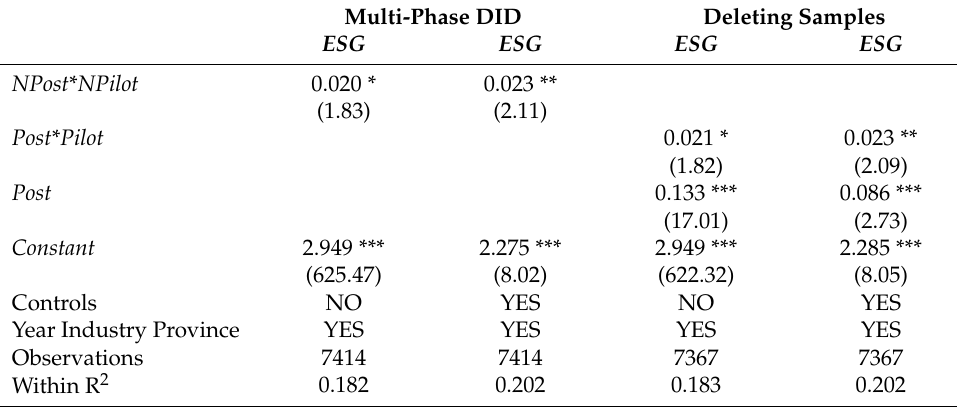
Table 10. Robustness check: multiple-stage DID and deleting